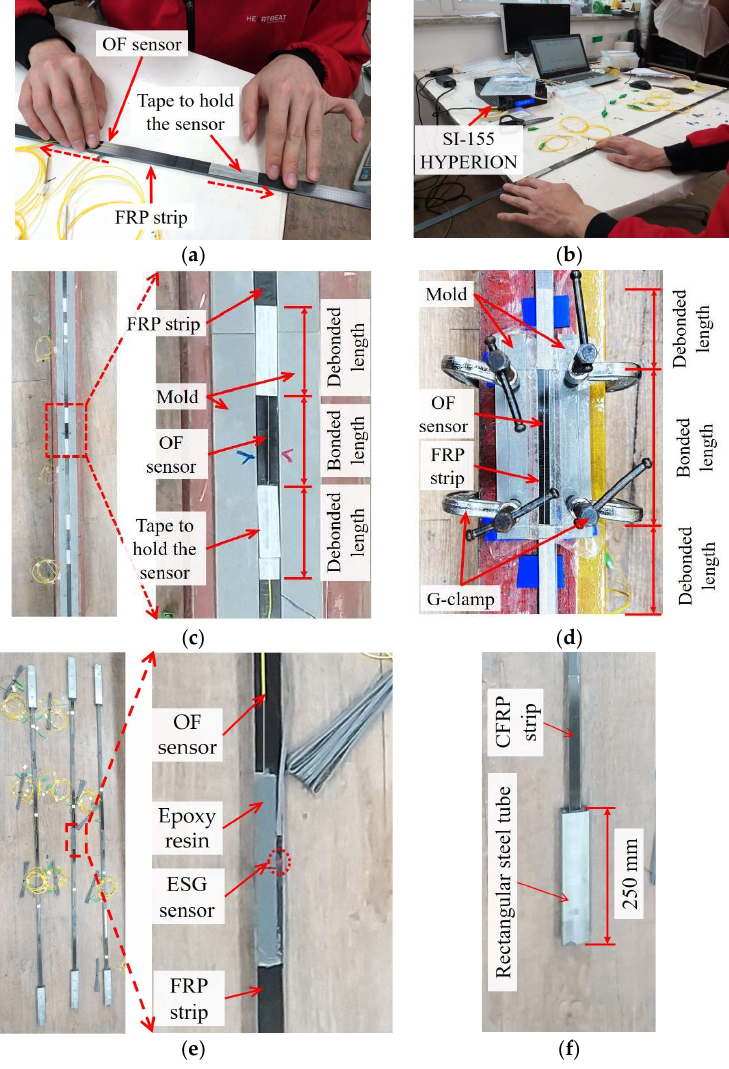
Figure 8. Fabrication process of FBG-FRP composite: ( a ) Applying a small prestress on the FBG-OF sensor; ( b ) Controlling the small prestress; ( c ) Embedded bonding method; ( d ) External bonding method; ( e ) FBG-FRP test specimens; ( f ) Ending